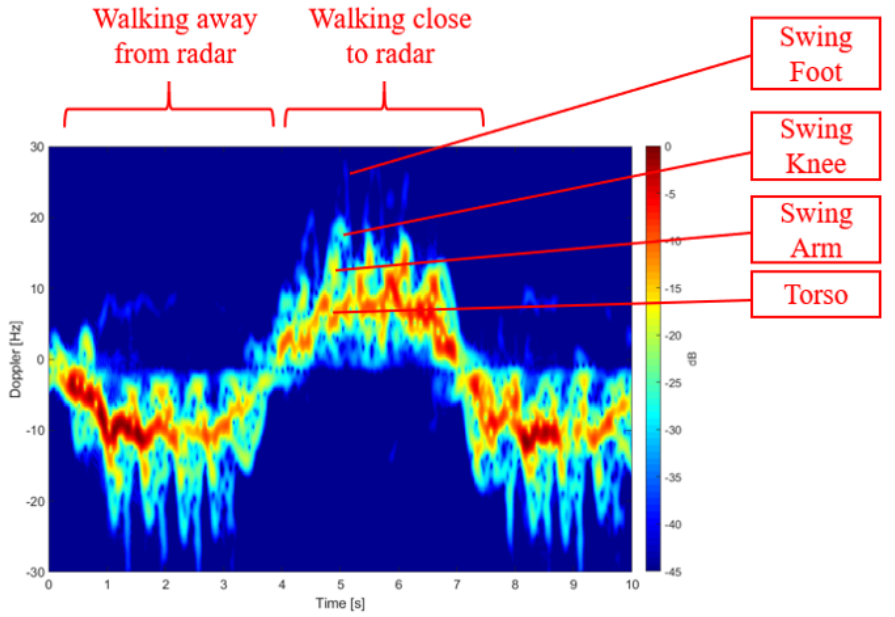
Figure 5. Example of micro-Doppler spectrogram of a walking